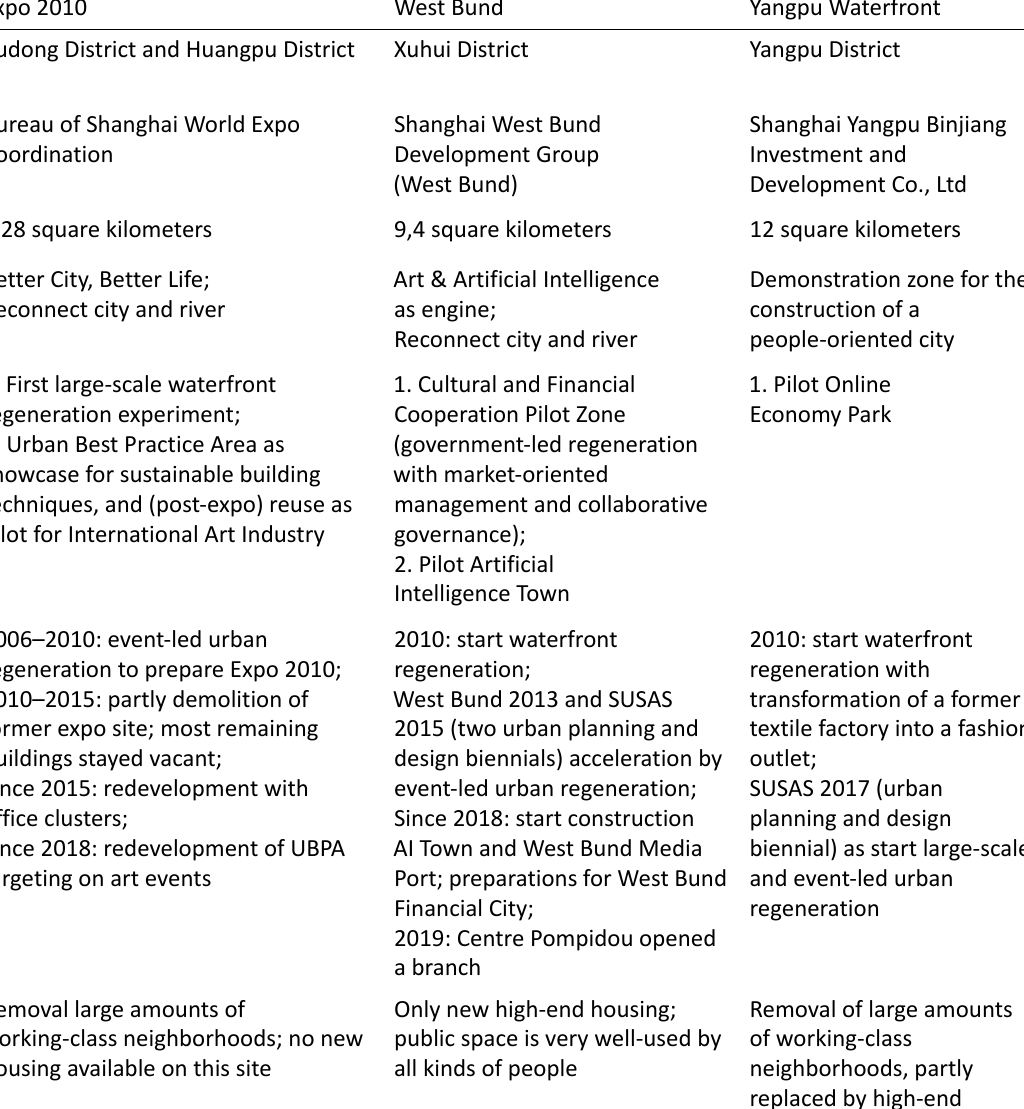
Table 1. The three cases compared on several aspects. Expo